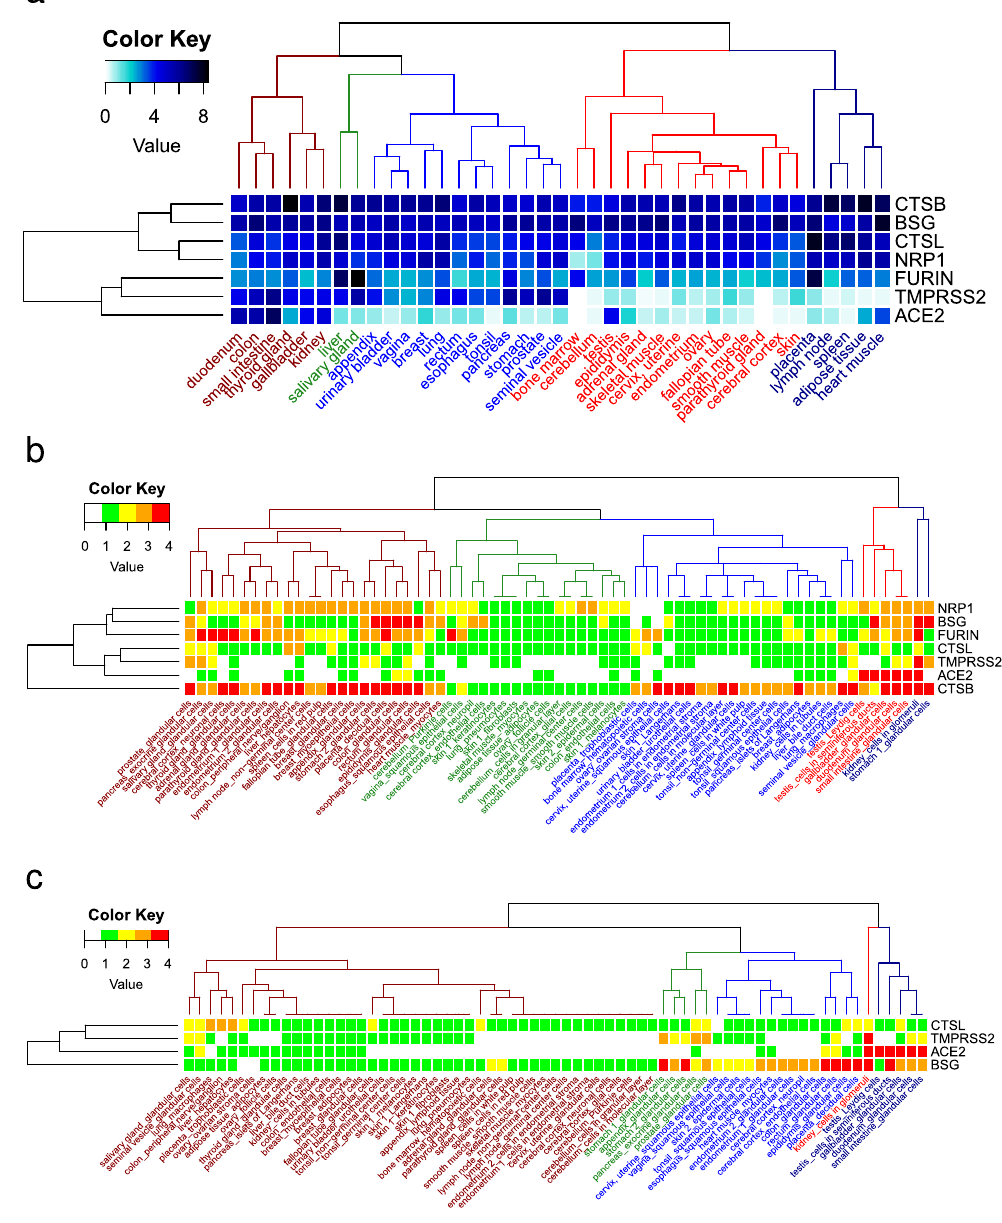
Figure 2. Cell and tissue heatmap based on potential input genes/proteins. ( a ) SARS-CoV-2, 39 tissues and seven messengers. Consistent with what is reported in the figure above, ACE2 and TMPRSS2 have the lowest expression, followed by FURIN. Of the 39 tissues, bone marrow, cerebellum and parathyroid gland have the lowest expression of ACE2 and TMPRSS2. The white to blue colored scales represent the Expression value provided by ProteinAtlas. ( b ) SARS-CoV-2, 69 cell types and seven proteins. In the red and dark blue branches and later in the dark red branch, the cell types with the highest protein presence are concentrated. Green and blue branches group those cell types with lower presence, as well as those without ACE2 or TMPRSS2 (also in the dark red branch), mainly. ( c ) SARS-CoV-1, 69 cell types and 4 proteins. The dark red branch is where the cells with the lowest presence of protein or mRNA are grouped; in the central part, the 14 removed cells are observed. The color represents the Expression value, white (not reported at either the transcript or protein level), green (only present at the transcript level), yellow (low amount of protein reported), orange (intermediate amount of protein reported), and red (high amount of protein